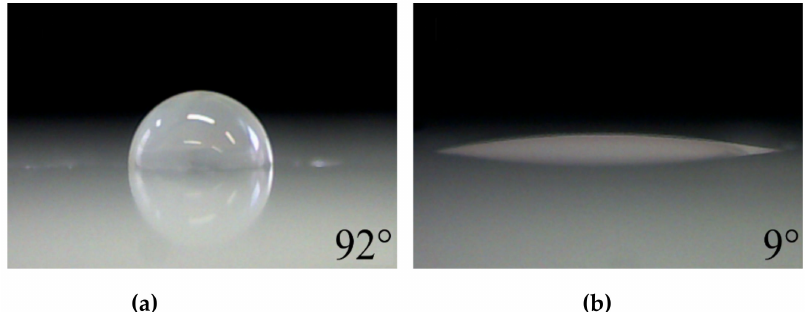
Figure 4. The images of water sessile drop on: ( a ) untreated sample; and ( b ) on the sample after 15 seconds of plasma treatment. Images shown for a processing gas with a volume concentration of P-B of 0.8%